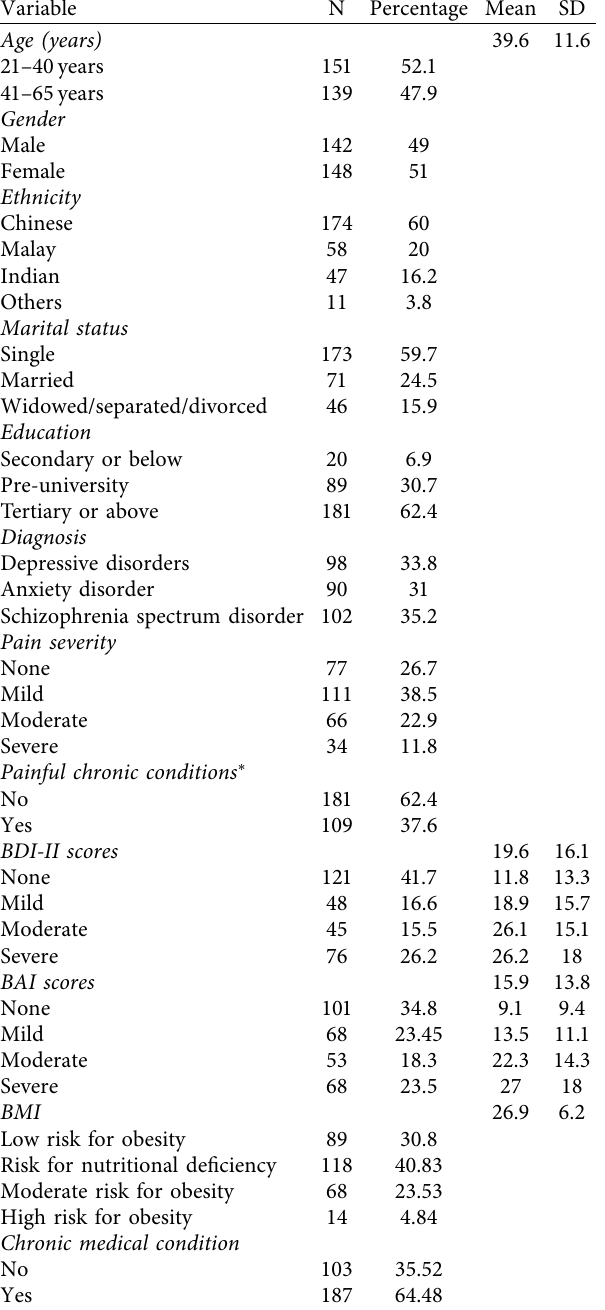
Table 1: Descriptive statistics of sociodemographic and clinical characteristics of the study